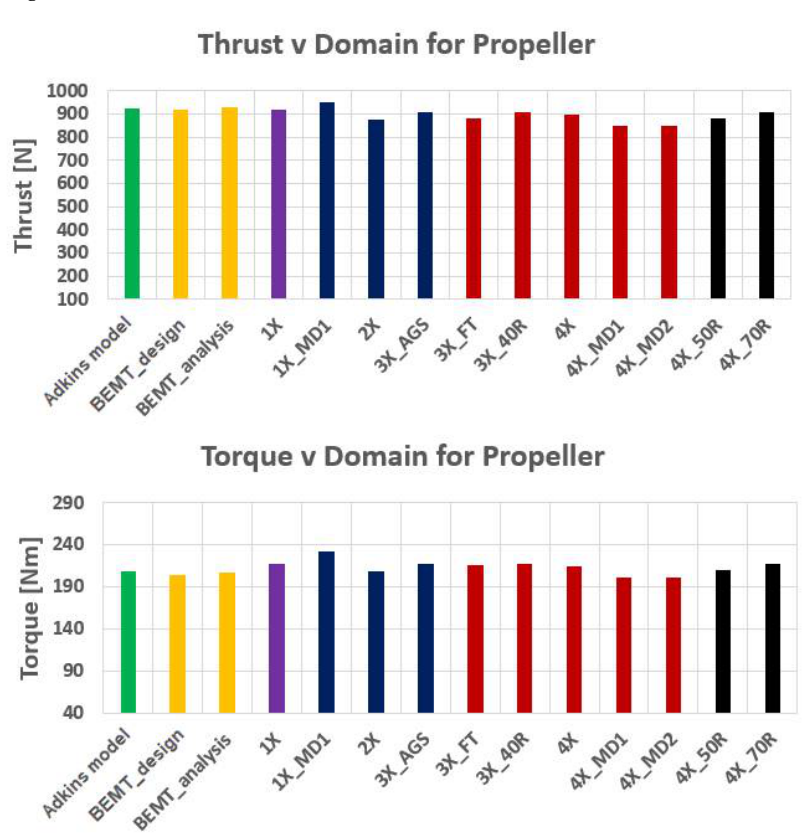
Figure 13. 3DCFD domain sizes compared with BEMT model with thrust and torque values for each domain. 4X_MD1 and 4X_MD2 are different mesh density for 4X domain. domain. 4X_MD1 and 4X_MD2 are different mesh density for 4X domain. Table 2. Performance of various 3DCFD domain sizes are compared with py_BEM